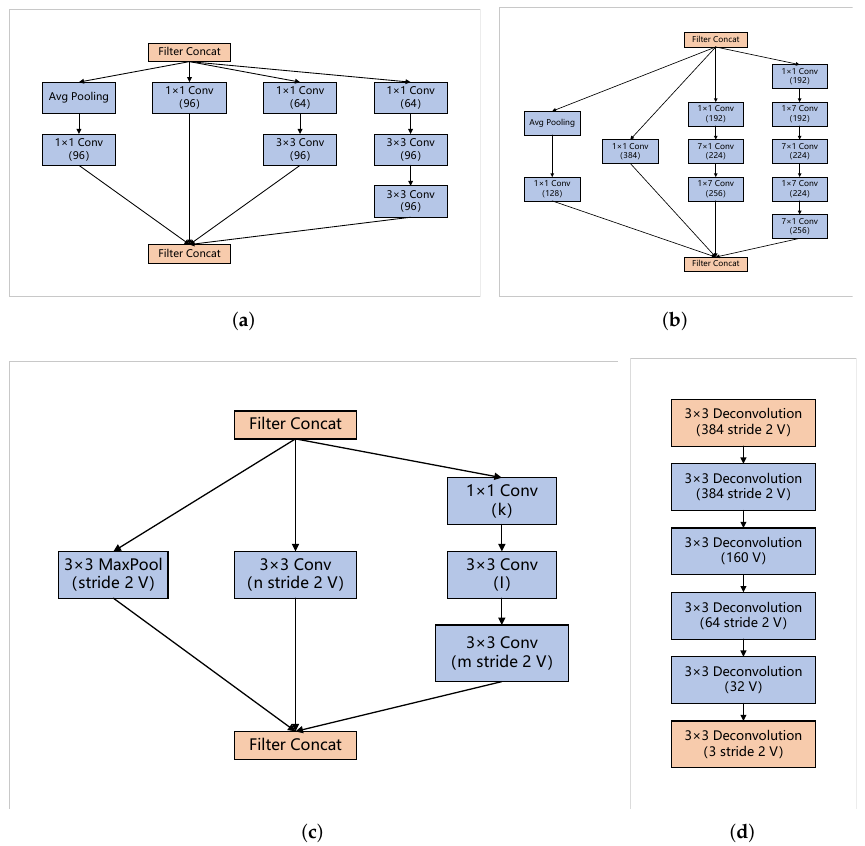
Figure 5. Module details: ( a ) Inception_A; ( b ) Inception_B; ( c ) Reduction_A; ( d )